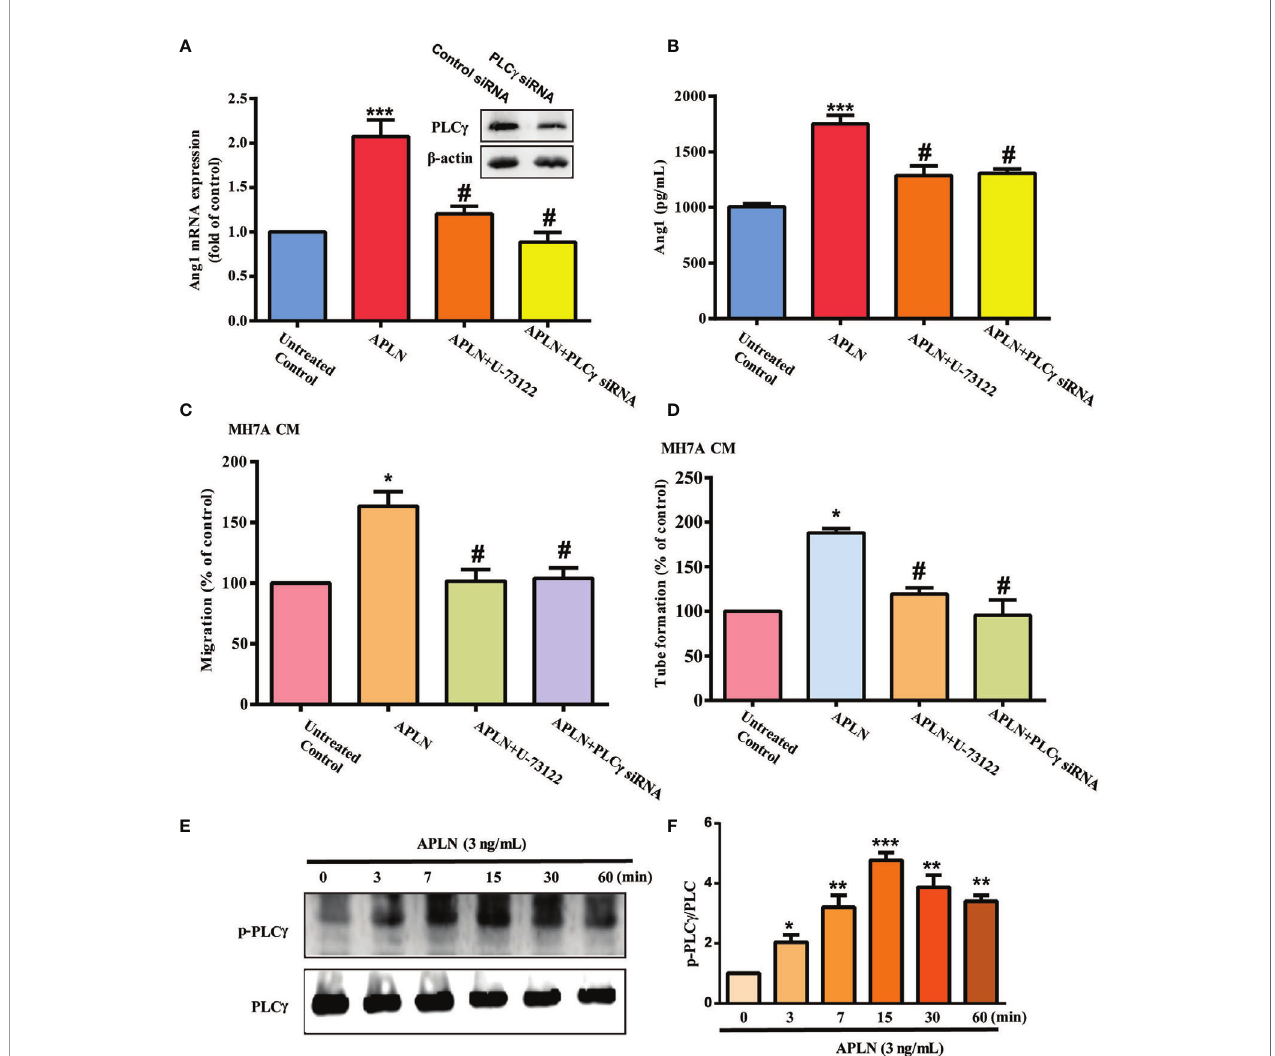
FIGURE 2 | PLC g signaling regulates APLN-induced effects on Ang1 expression and EPC angiogenesis. (A, B) RASFs were left untreated, stimulated with APLN (3 ng/mL) alone for 24 h, or pretreated with U73122 for 30 min, or transfected with PLC g siRNA for 30 min, prior to 24 h of APLN (3 ng/mL) stimulation. Ang1 expression was examined by qPCR and ELISA assays. (C, D) Collected CM was applied to EPCs, and angiogenesis was determined. (E) RASFs were treated with APLN for varying amounts of time and Western blot (n=3) determined PLC g phosphorylation. (F) Densitometry analysis of (E) . * p < 0.05, ** p < 0.01 and *** p < 0.001 versus the control group; # p < 0.05 versus the APLN-treated